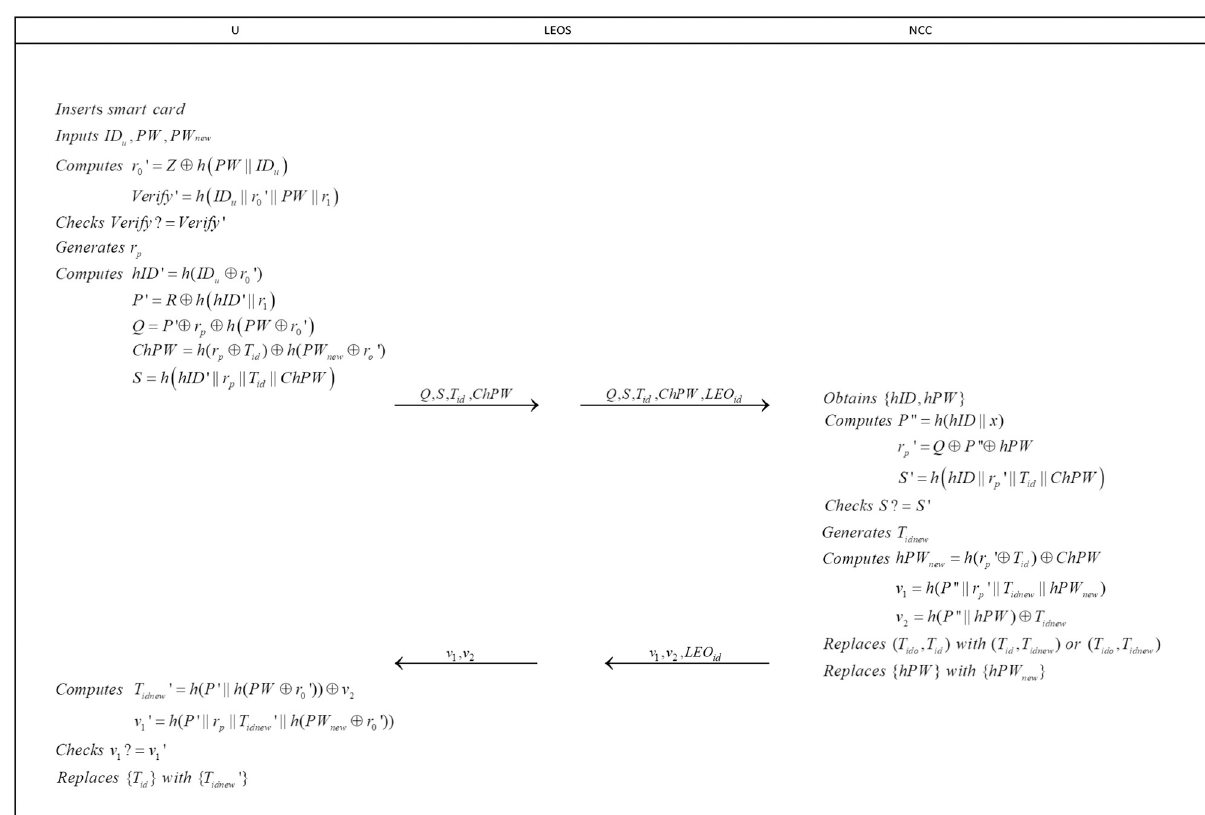
Fig 4. Password update